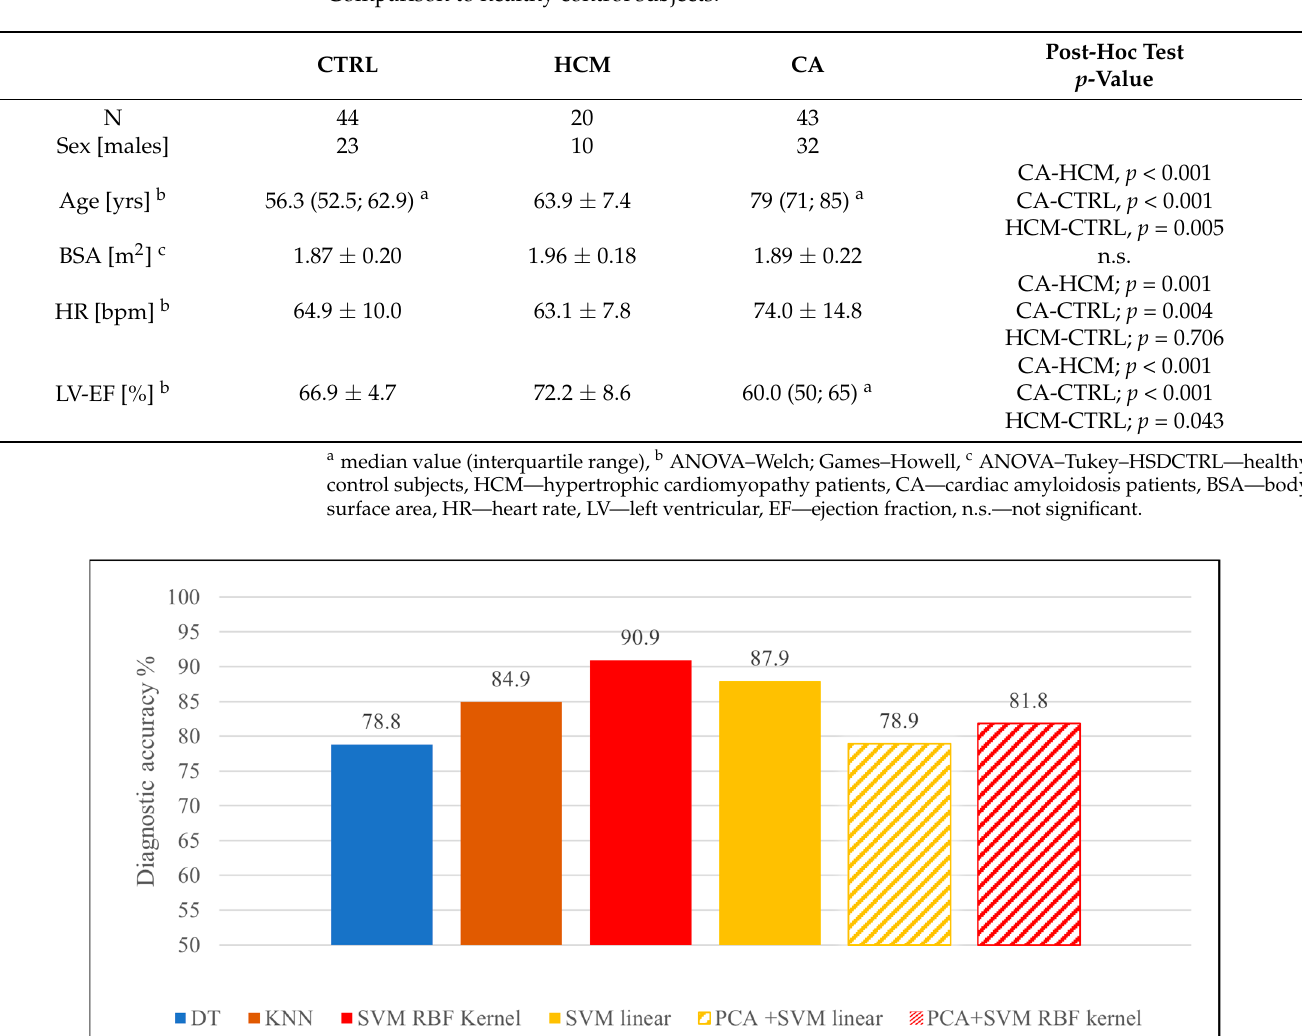
Table 1. Baseline parameters of patients with cardiac amyloidosis and hypertrophic cardiomyopathy. Comparison to healthy control subjects.